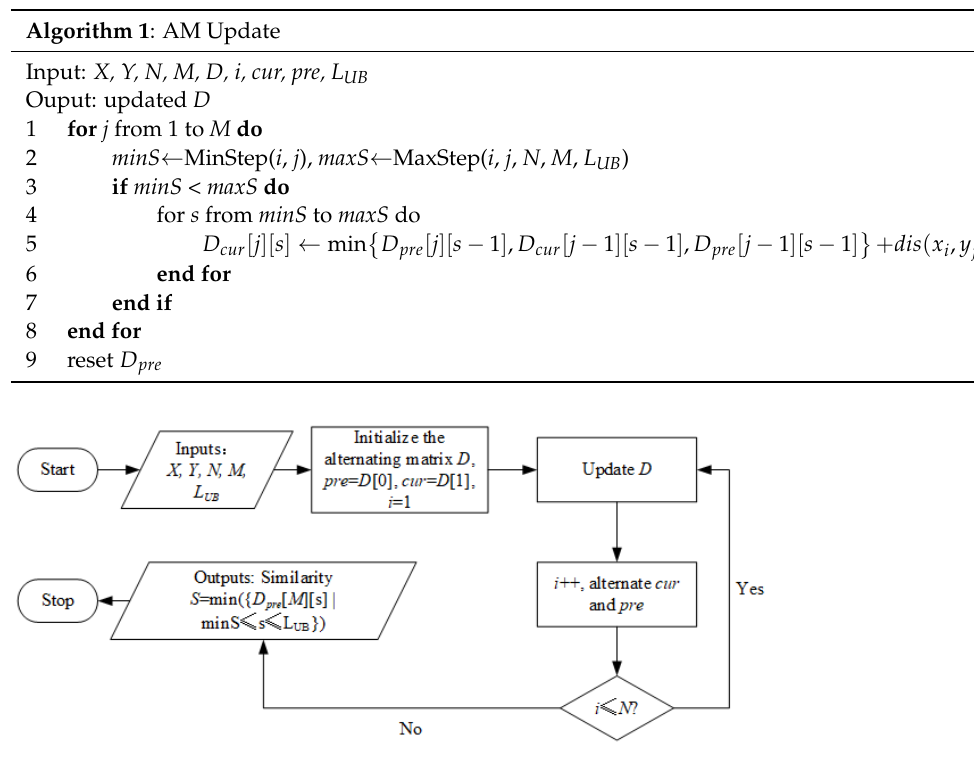
Figure 4. The workflow of the proposed similarity calculation process.